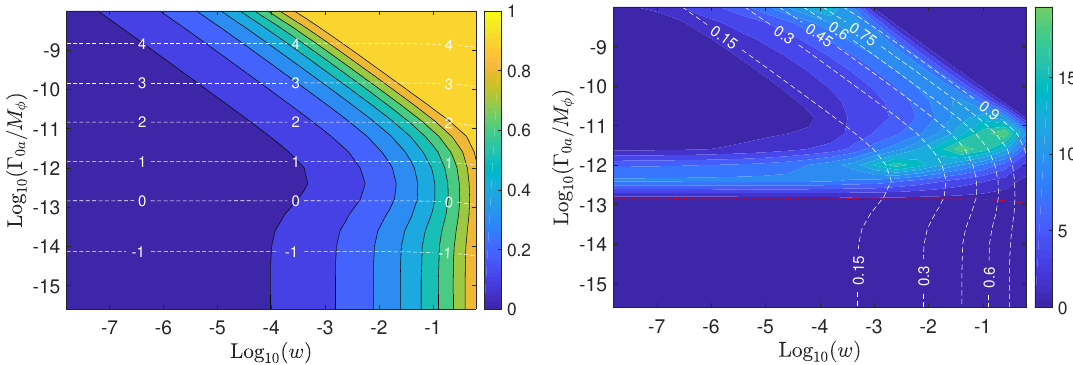
Figure 8. Left panel : contours of the (cid:12)nal temperature ratio obtained numerically, x f;n = T b =T a , shown in color, for the case when the in(cid:13)aton is coupled to scalars in both sectors. The white dashed lines show contours of log ( T rh =M (cid:30) ). Right panel : contours of relative fractional discrepancy, 10 j x f;a (cid:0) x f;n j =x f;n , where x f;a is the analytic estimate of eq. (4.16) with eq. (4.15), in percent. The white dashed contours depict x f;n and the red dashed line marks the region where T rh = M (cid:30)